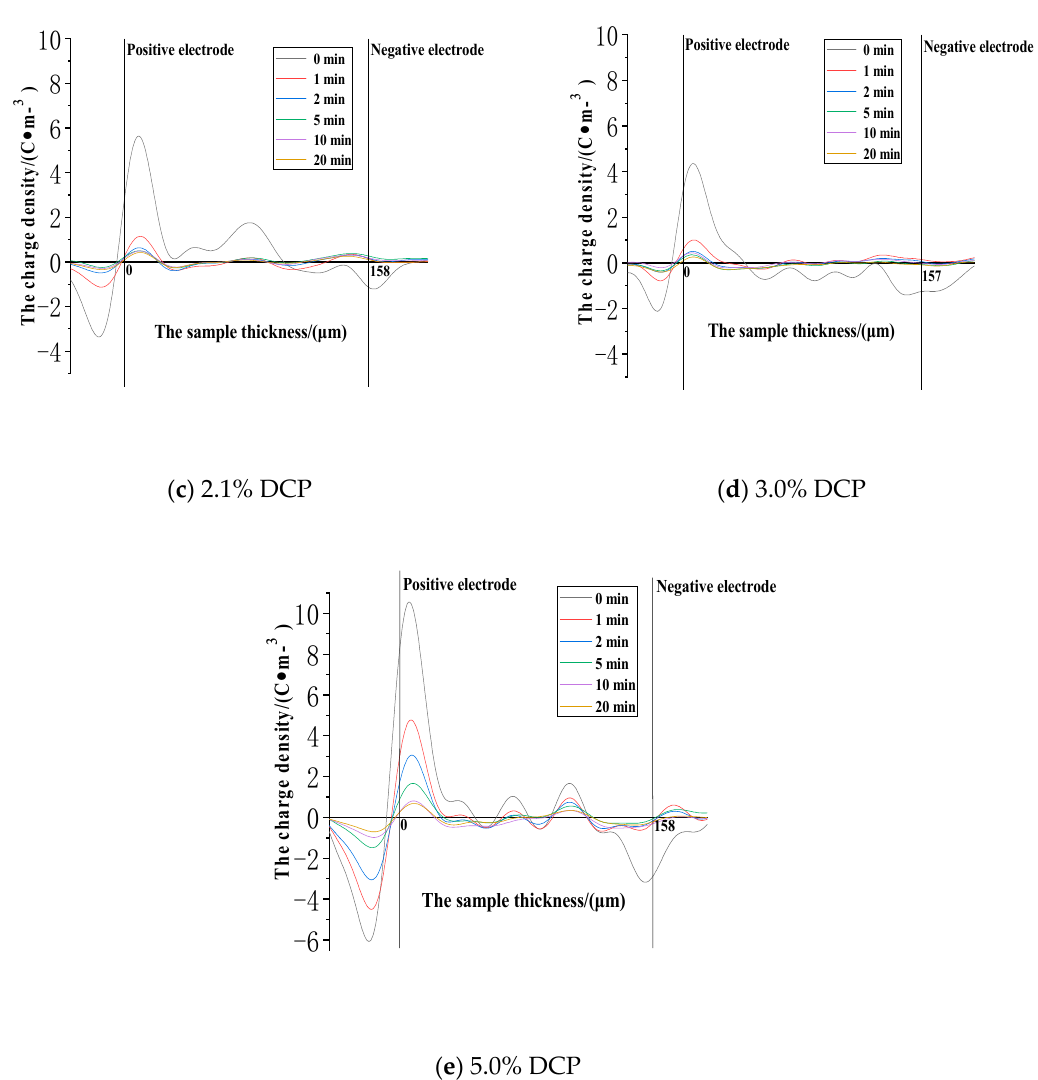
Figure 7. The space charge distribution when each sample experiences de-voltage after the action of 30 kV / mm. ( a ) The experimental results of the pure LDPE samples. ( b ) The experimental results of the samples with 1.0% DCP. ( c ) The experimental results of the samples with 2.1% DCP. ( d ) The experimental results of the samples with 3.0% DCP. ( e ) The experimental results of the samples with 5.0% DCP.